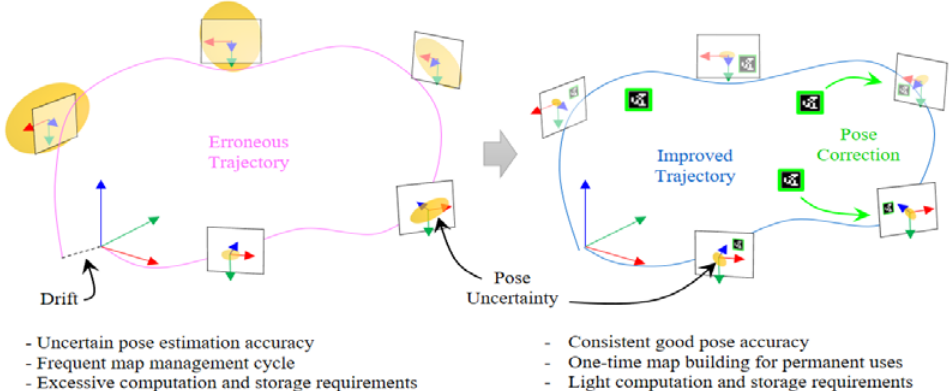
Figure 2. Advantage analysis using marker-based pose adjustment for instant global localization in an offshore plant.